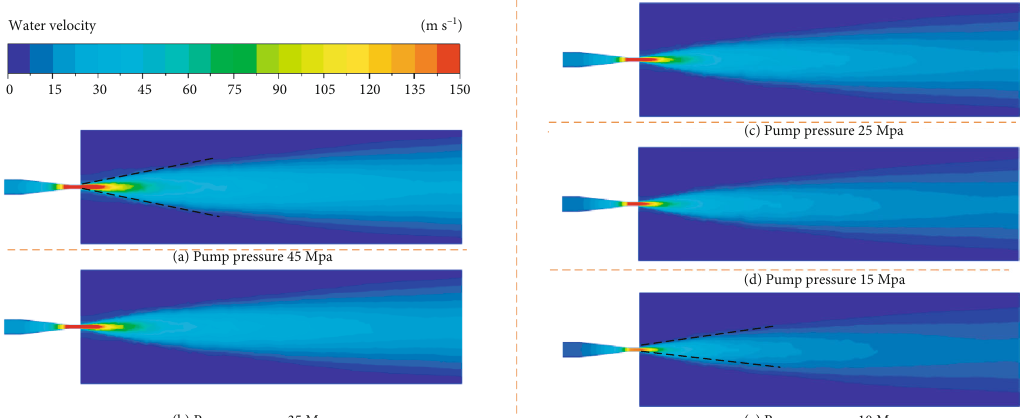
Figure 12: HPWJs generated at di ff erent pump pressures.